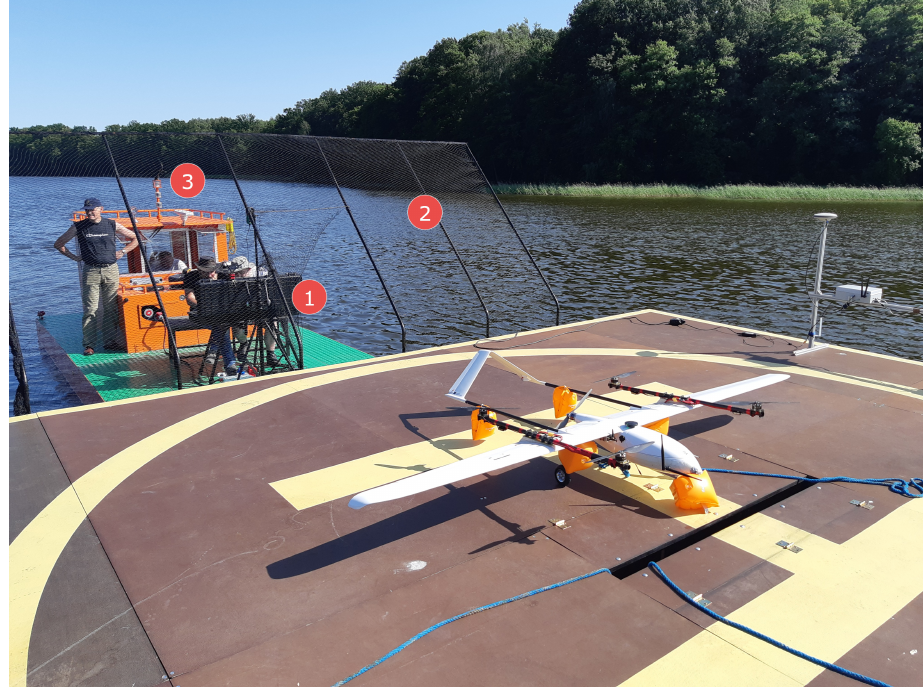
Figure 6. Albatross VTOL and floating landing pad view, 1—UAVs’ ground control station, 2—a safety net, 3—a push barge.